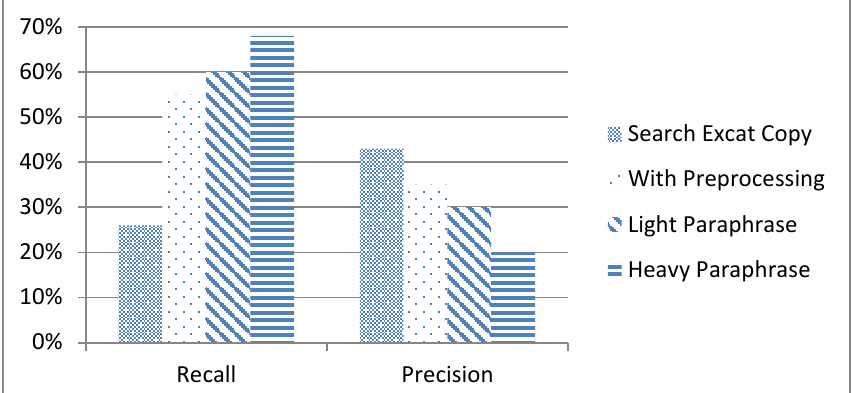
Figure 13.Evaluating ParaMaker in Persian language on IranDoc